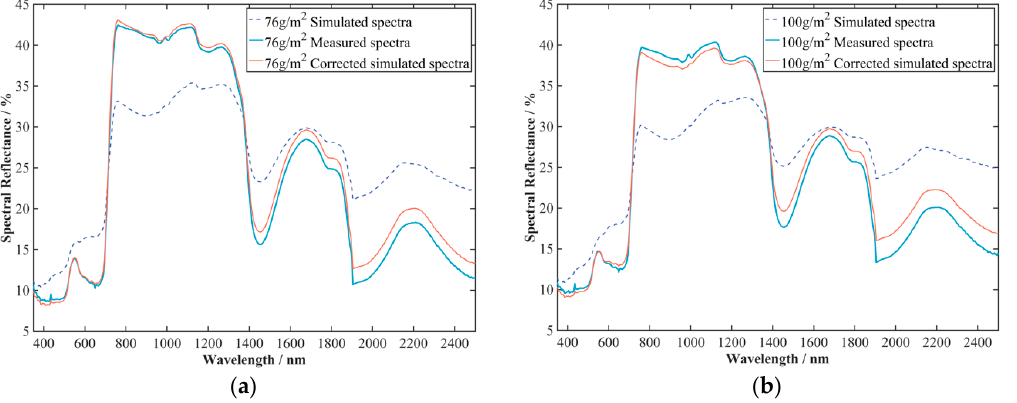
Figure 7. The simulation spectrum results after error correction, and the results were calculated from Equations (21) and (22).